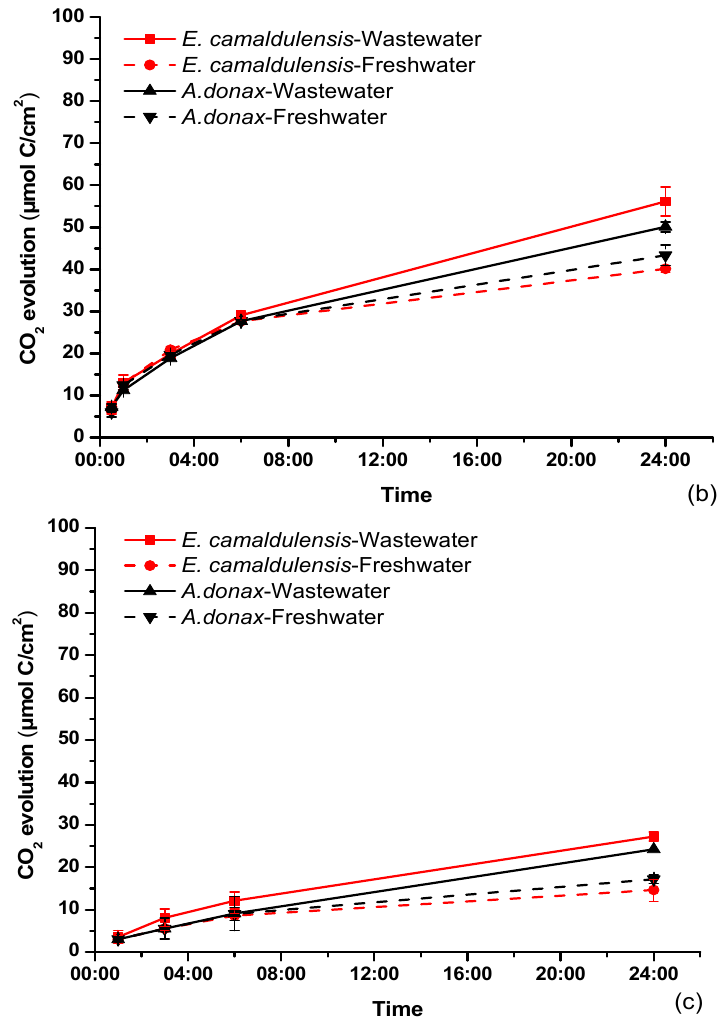
Figure 3. Emitted CO 2 from pots planted with E. camaldulensis and A. donax plants and irrigated with primary treated wastewater and fresh water on ( a ) 28 June; ( b ) 25 August; and ( c ) 6